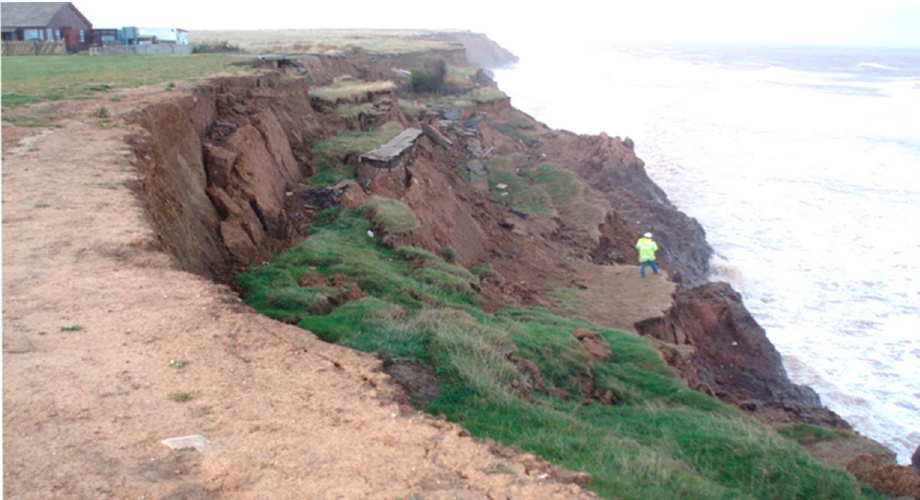
Figure 6. Rotational landsliding is the primary mechanism at Aldbrough.